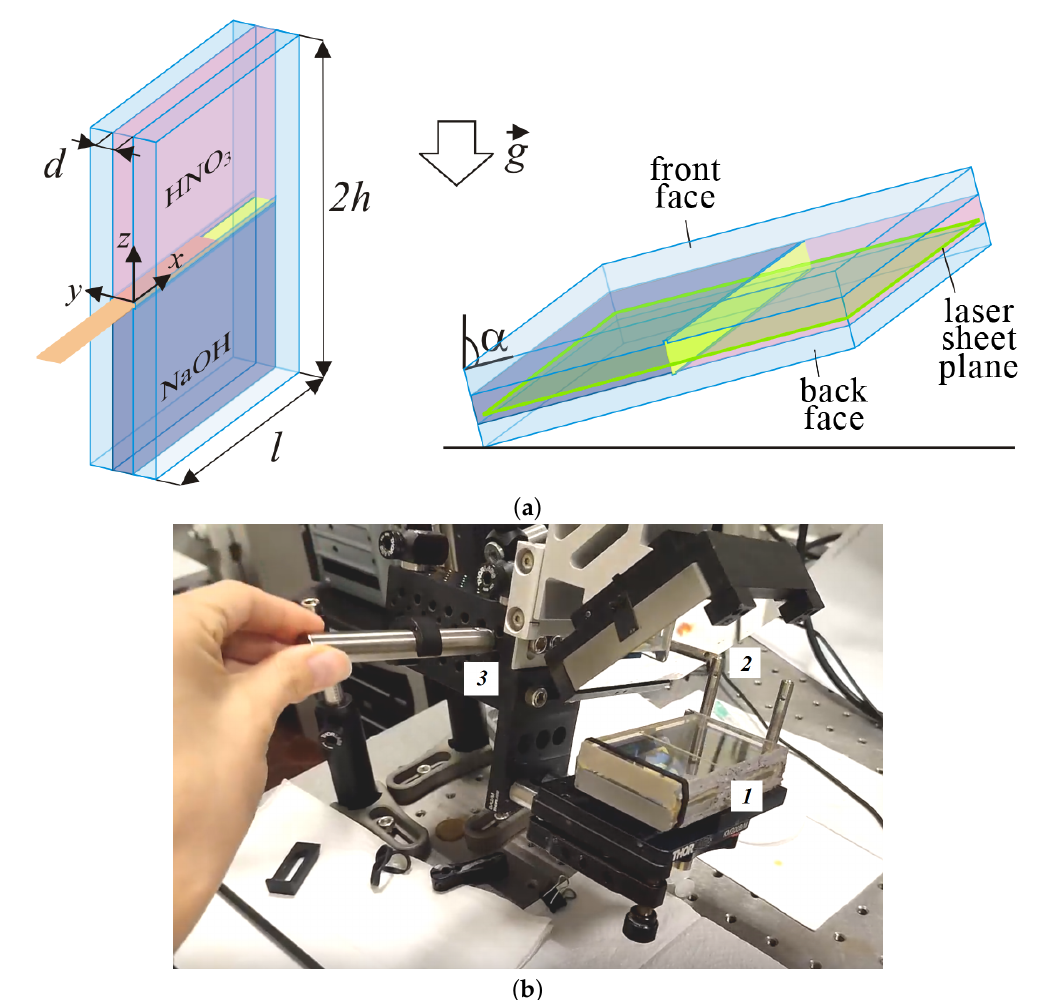
Figure 1. ( a ) Schematic diagram of an experimental two-layer system of miscible liquids filling a rectangular slot inclined at an angle α to gravity. The green frame in the right image indicates the location of the laser sheet plane. ( b ) Photo of the general view of the laboratory setup: 1 —the rectangular interferometric cell with a two-layer system; 2 —a mirror that makes it possible to obtain a reflected light interferometry image; 3 —the rotary system for changing the angle of inclination of the experimental